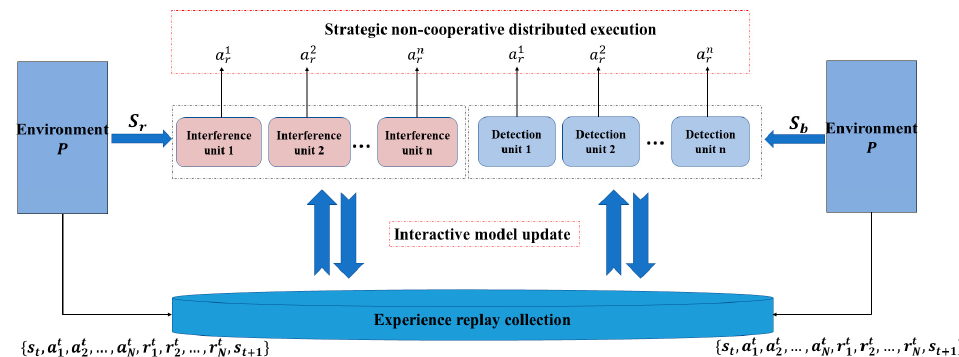
Figure 6. A framework for multi-agent interactive learning.